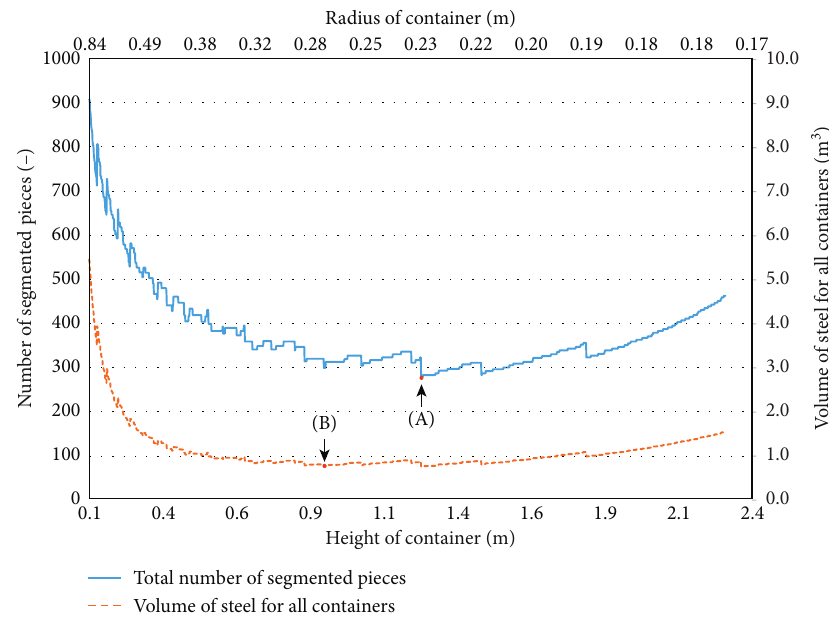
Figure 15: Total number of segmented pieces and volume of steel used for manufacturing all containers with increasing height (or decreasing radius) of 200 L container. (A) and (B) are the points of the minimum values for the total number of segmented pieces and the volume of steel for all containers,